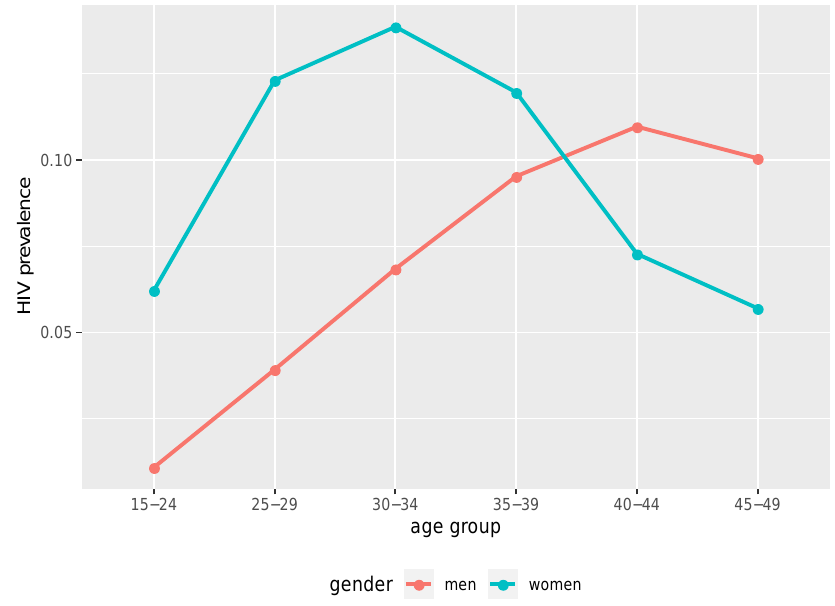
Figure 1. HIV point prevalence at 40 years of simulation time from the simulated epidemic. Age and gender structured point prevalence from benchmark data (2017 in calendar